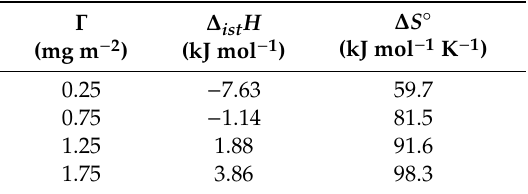
Table 6. Isosteric heat of adsorption ( ∆ ist H ) and standard entropy of sorption ( ∆ S ◦ ) at di ff erent uptakes ( Γ ), of atrazine onto solid HA at T = 25 ◦ C (adapted from